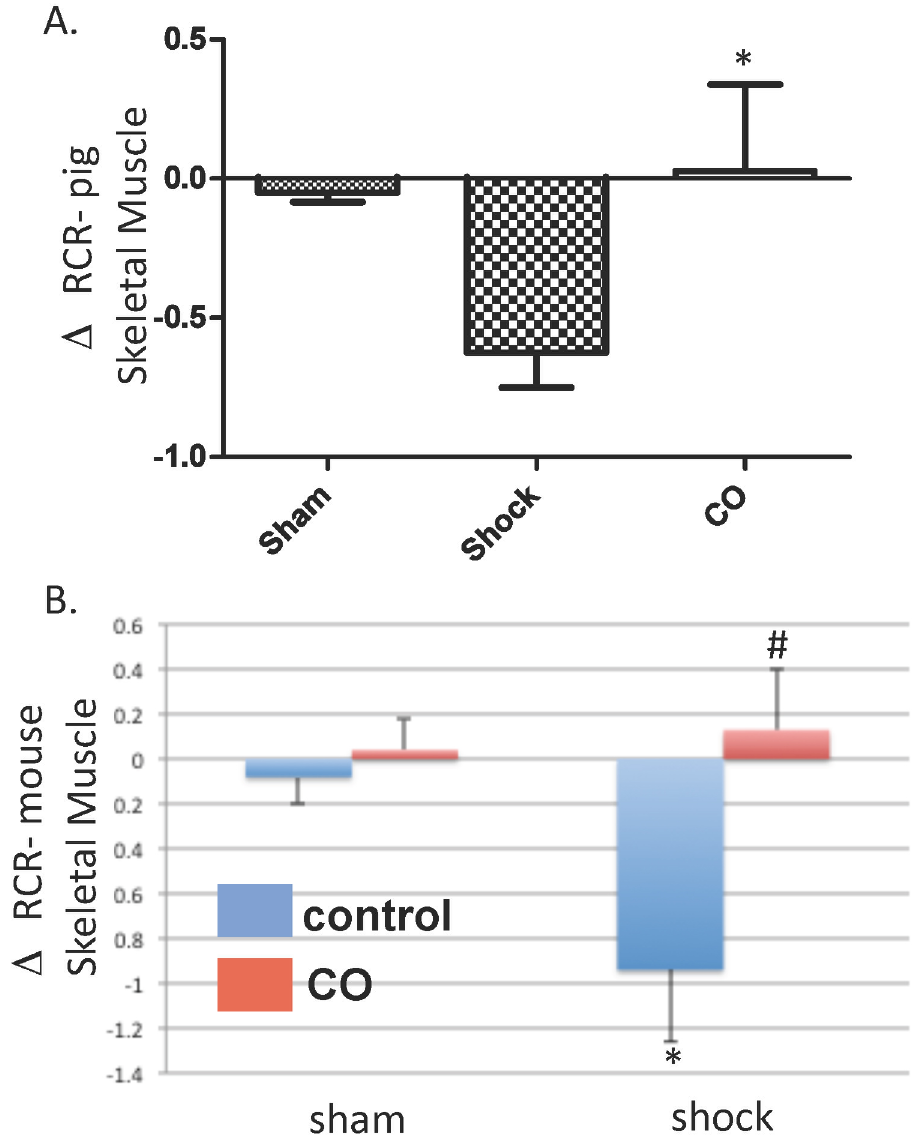
Fig 6. Hemorrhagic shock and resuscitation-induced skeletal muscle mitochondrial injury was limited by CO therapy. A. The change in respiratory control ratio (RCR; state 3:state4) from baseline to 2 hours after resuscitation in the porcine model demonstrated that HS/R led to mitochondrial injury. CO treatment resulted in an overall increase in the mean RCR, representing decreased mitochondrial injury ( * P < 0.05 compared to HS/R). B. Changes in RCR in murine thigh skeletal muscle from baseline to 2 hours after resuscitation demonstrated mitochondrial injury following HS/R, and inhaled CO protected against this injury (N = 8 mice per group; * P < 0.05 compared to baseline; #P < 0.05 compared to control treated-HS/R mice). ANOVA was utilized for above